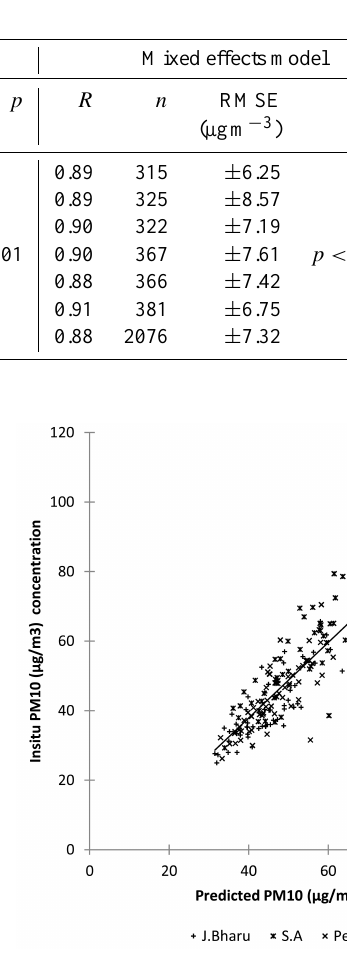
Table 3. Long-term comparison on linear regression model and mixed effects model on PM 10 -AOD and RMSE (µgm − 3 ) of annual MODIS estimated PM 10 concentration.